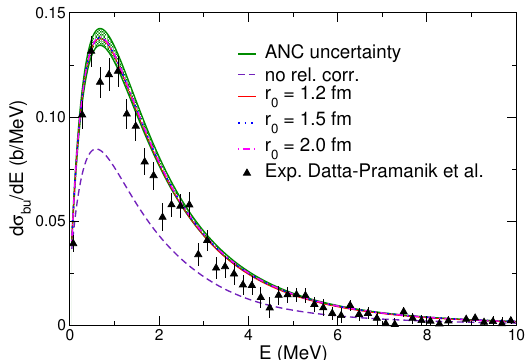
Figure 5: Cross sections for the breakup of 15 C on Pb at 605 MeV / nucleon expressed as a function of the c -n relative energy E after dissociation. Coulomb-corrected eikonal calculations [ 26 ] are compared to the experimental data of Ref. [ 25 ] .